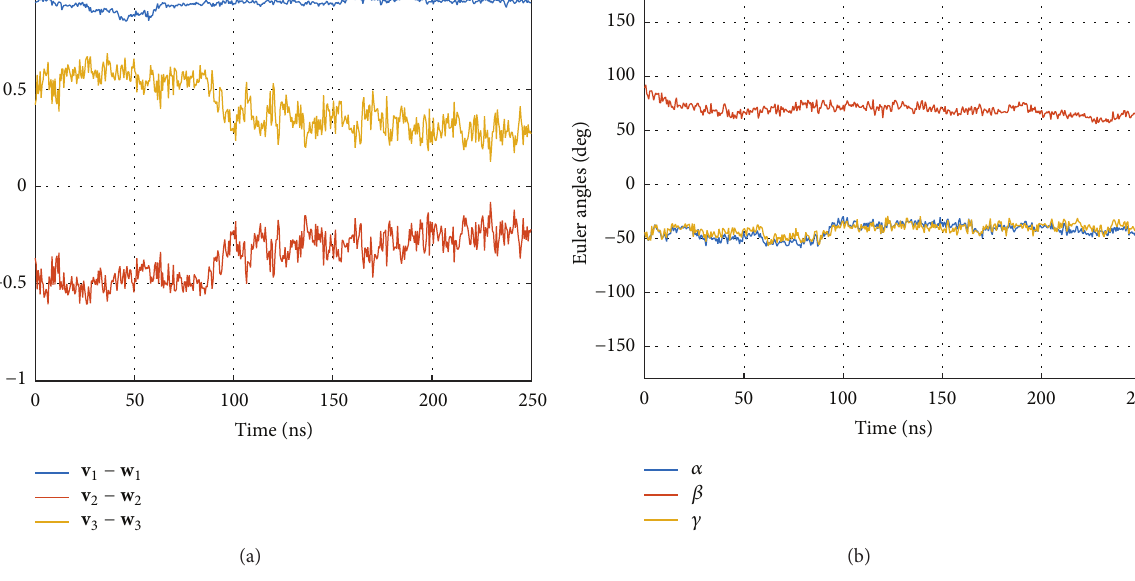
Figure 9: Relative movements of helices G 𝛼 1 and G 𝛼 2 in absence of CD8. (a) Cosines between corresponding eigenvectors. (b) Euler angles between corresponding